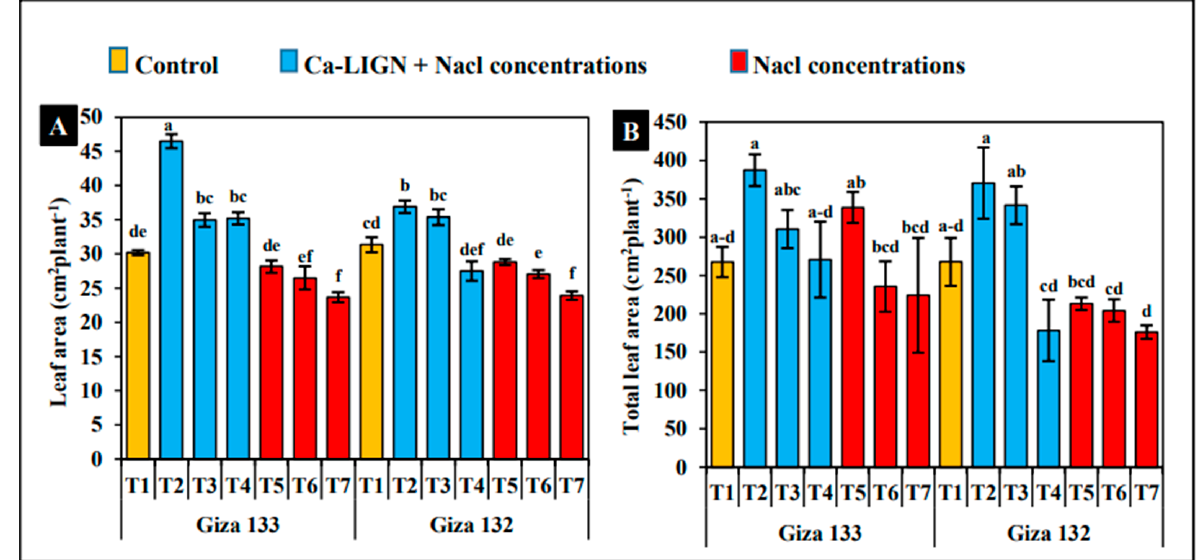
Figure 3. Effect of different treatments: (T1) control, (T2) 100 mM NaCl + Ca-LIGNO, (T3) 200 mM NaCl + Ca-LIGNO, (T4) 300 mM NaCl + Ca-LIGNO, (T5) 100 mM NaCl, (T6) 200 mM NaCl, and (T7) 300 mM NaCl on the average ( A ) leaf area (LA) and ( B ) total leaf area (TLA) of the two barley cultivars, Giza133 and Giza132, during two seasons, 2019/2020 and 2020/2021. Data represent the mean ± SE (n = 4). The same letter indicates no significant difference ( p ≤ 0.05).